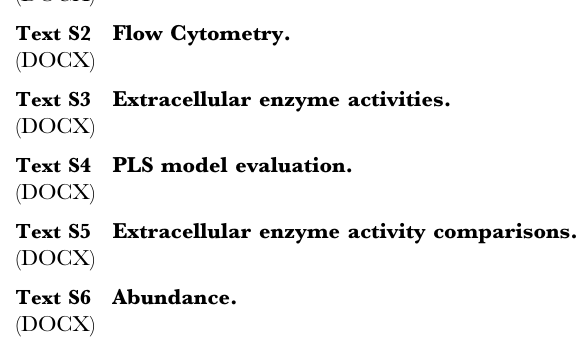
Table S1 Overview of extracellular enzyme activities measured along gradients within the bioreactors. The specific reaction performed and EC (Enzyme Commission) numbers are shown for each enzyme. The substrate analogues used for the enzyme activity measurements are also